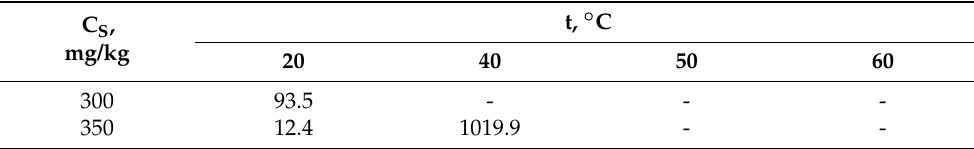
Table 6. Values of the final mean size of silica particles (nm) under different temperatures t and initial concentrations of solution C s , pH = 8; (-) means that it was not